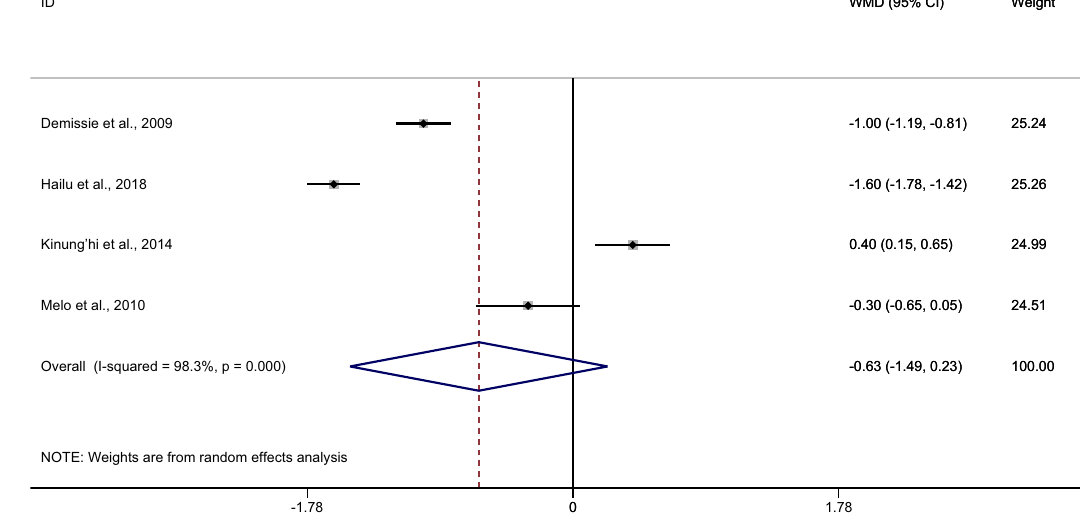
Figure 6. Mean haemoglobin levels between patients with Plasmodium spp. and hookworm co-infection and Plasmodium mono-infection. WMD weighted mean difference, CI confidence interval.